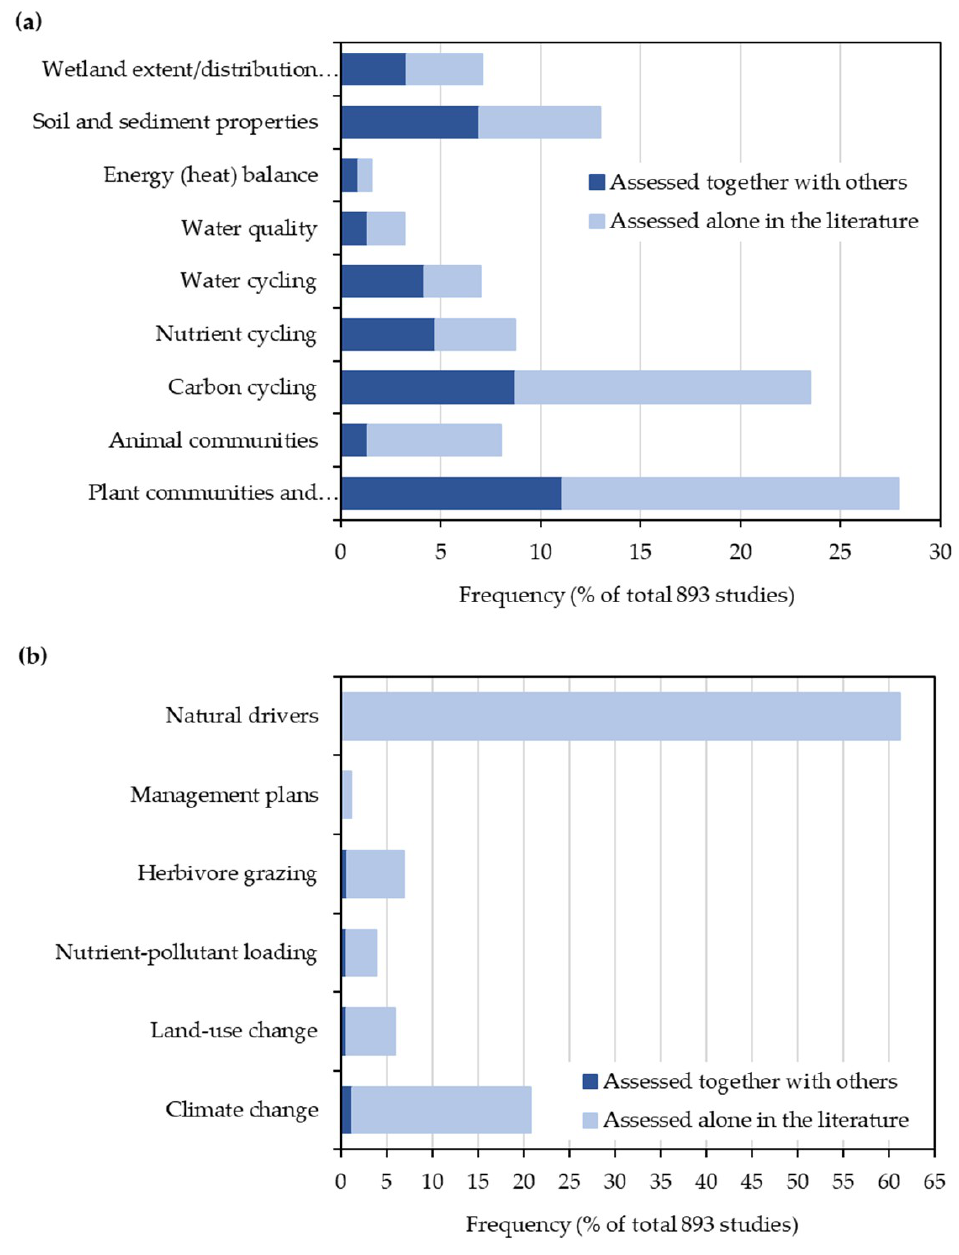
Figure 3. Share of studies addressing an individual characteristic/driver (light blue bars) or several characteristics/drivers (dark blue bars) for: ( a ) characteristics; ( b ) change drivers. (For interpretation of the colors in this figure, the reader is referred to the web version of the article.).